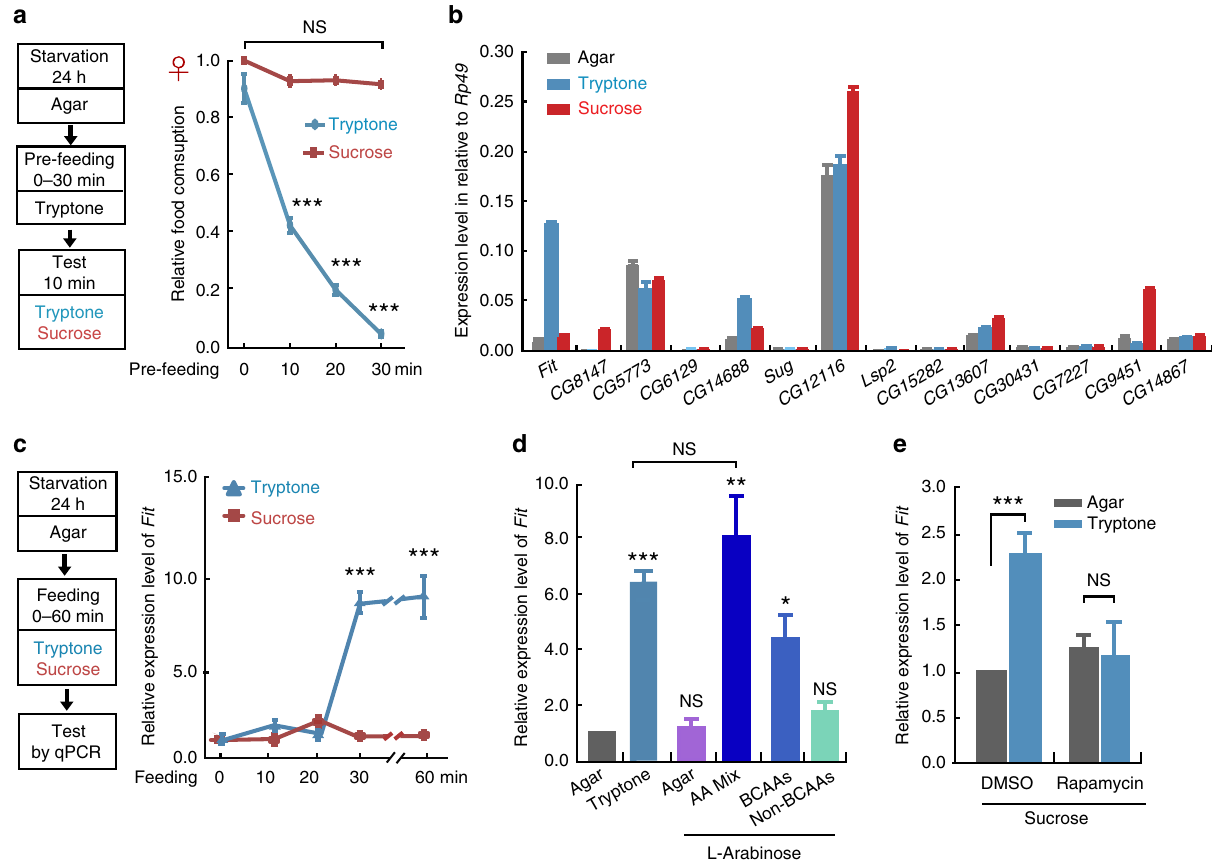
Figure 1 | Fit expression specifically responds to protein intake. ( a ) Along the increase of tryptone pre-feeding time, tryptone intake, but not sucrose intake, decreased significantly in WT flies. n ¼ 6–15. P (Food*Time) ¼ 1.03E-23 (two-way ANOVA, Bonferroni test). ( b ) Gene expression levels (normalized to Rp49 ) in flies after 24h-starvation, or after sucrose or tryptone feeding for 30min following starvation. Among the 14 genes tested, Fit showed a dramatic increase of gene expression after tryptone feeding, not, however, after sucrose feeding. n ¼ 3. ( c ) Fit expression was significant increased after 30min of tryptone feeding, while remained unchanged after sucrose feeding. n ¼ 3. P (Food*Time) ¼ 8.17E-8 (two-way ANOVA, Bonferroni test). ( d ) Fit expression increased at comparable levels after 30min feeding of tryptone and AA mix. BCAAs showed bigger effect than non-BCAAs in promoting Fit expression. n ¼ 3. One-way ANOVA, LSD’s post hoc test. ( e ) Tryptone feeding-induced Fit expression was blocked upon Rapamycin treatment. n ¼ 3. P (Food*Drug) ¼ 6.02E-4 (two-way ANOVA, Bonferroni test). L -Arabinose and sucrose served as the sweeteners in d and e , respectively. * P o 0.05; ** P o 0.01; *** P o 0.001. NS indicates no statistical significance. The data are mean ± s.e.m.